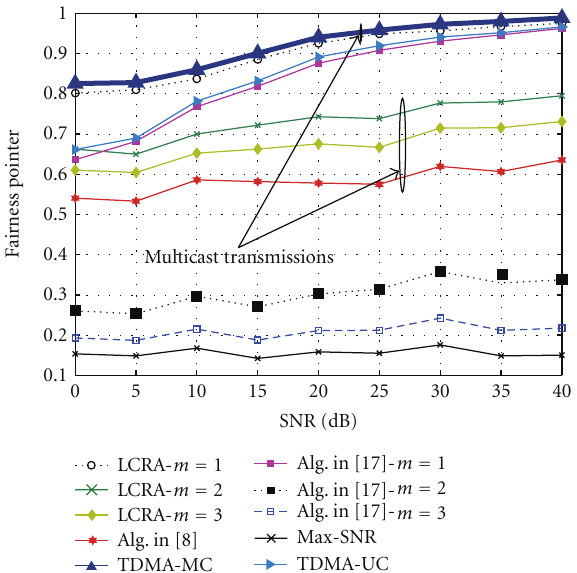
Figure 4: Fairness versus average SNR.